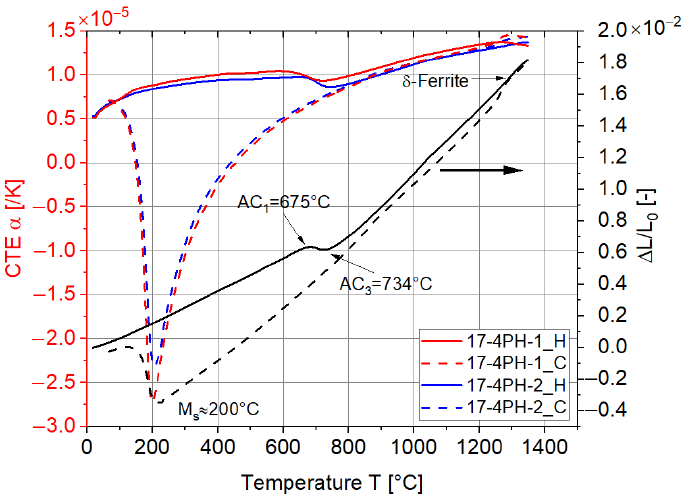
Figure 4. Length change and technical CTE results for 17-4PH during both heating and cooling stages.